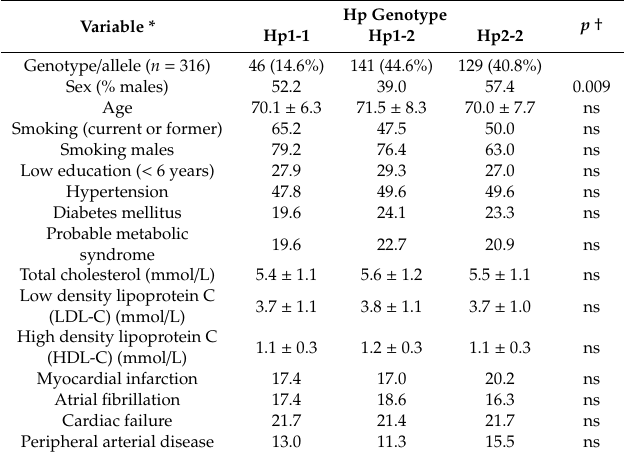
Table 1. Demographics of the Helsinki Stroke Aging Memory Study (SAM)